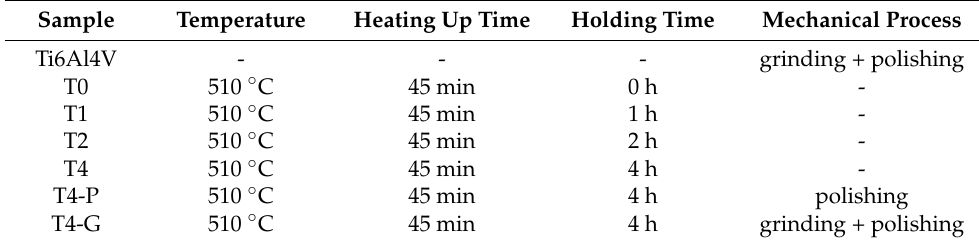
Table 2. The preparation process of different